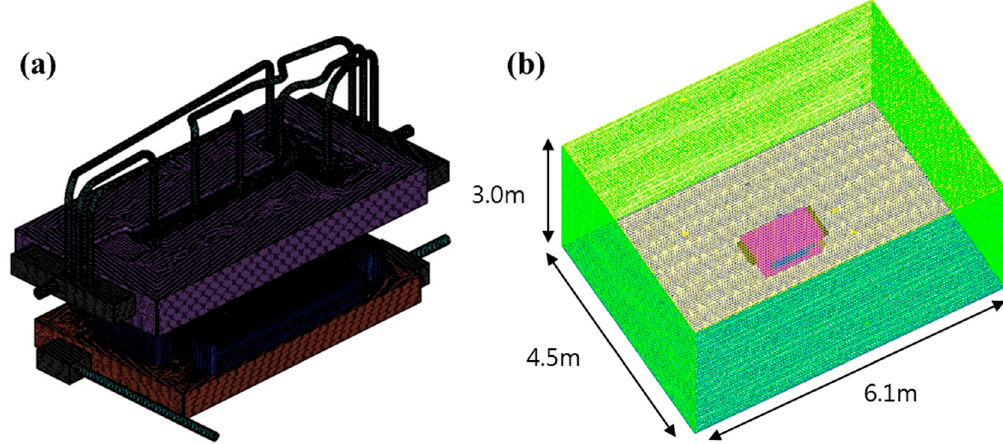
Figure 5. Meshed model of the numerical analysis ( a ) Solid part mesh; ( b ) Exterior volume